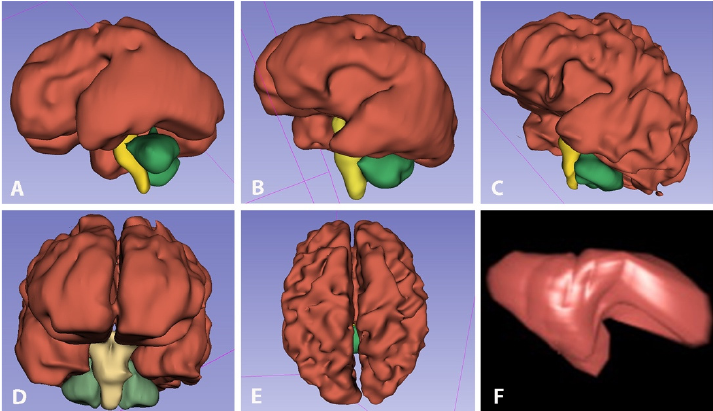
Figure 3. Fetal brain volumetric segmentations with 3D-Slicer. Sagittal views at 26 GW ( A ), 29 GW ( B ) and 33 GW ( C ). Interactive 3D visualization of cerebral hemispheres (red), brainstem (yellow) and cerebellum (green) in frontal ( D ) and craniocaudal ( E ) view. Three-dimensional ventricular volume rendering of moderate VM with VOCAL at 29 GW ( F ).